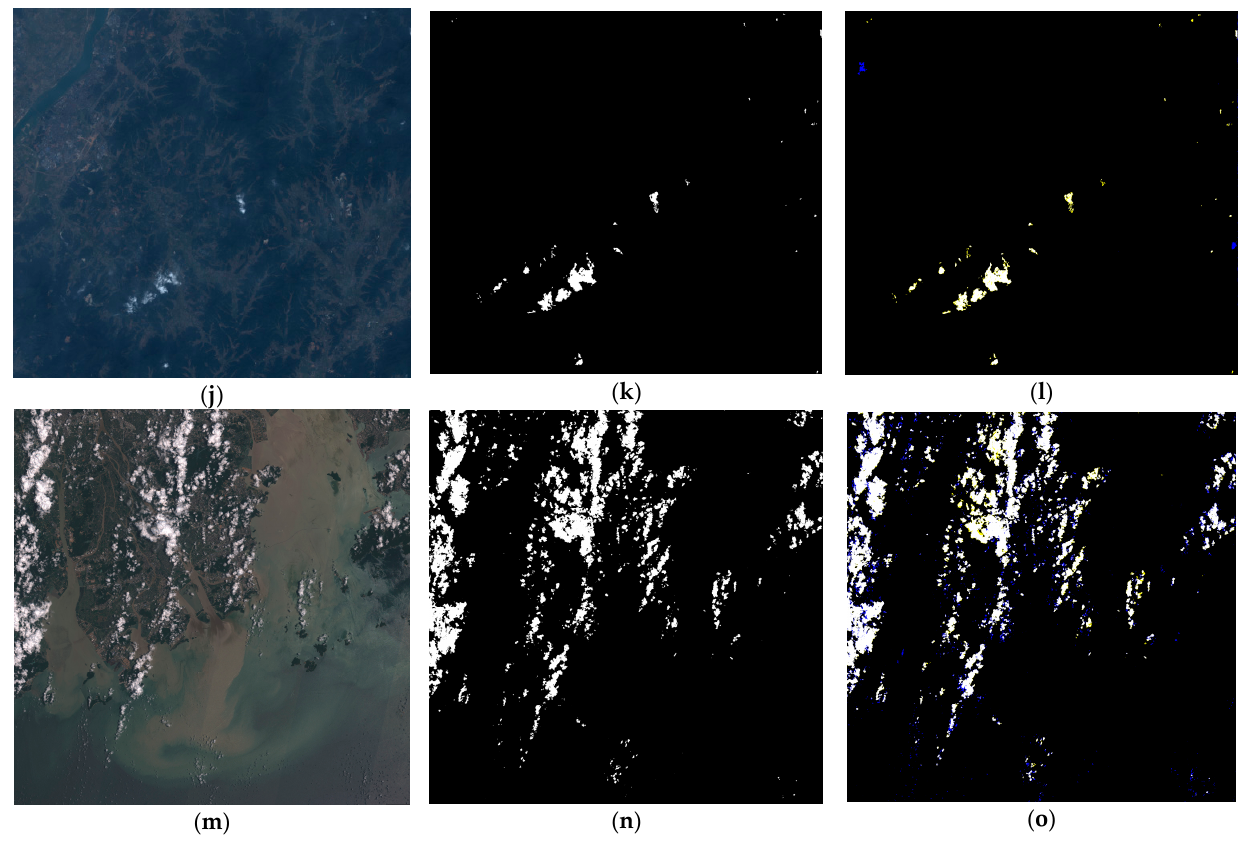
Figure 9. Cloud detection results of multi-source remote sensing imagery (the yellow areas indicate the missed extracted pixels and the blue areas indicate the wrong extracted pixels). ( a ) GF-1 WFV true color images. ( b ) ground truth. ( c ) cloud detection results. ( d ) GF-6 WFV true color images. ( e ) ground truth. ( f ) cloud detection results. ( g ) Landsat9 true color images. ( h ) ground truth. ( i ) cloud detection results. ( j ) Beijing-2 true-color images. ( k ) ground truth. ( l ) cloud detection results. ( m ) Sentinel-2 true-color images. ( n ) ground truth. ( o ) cloud detection result.